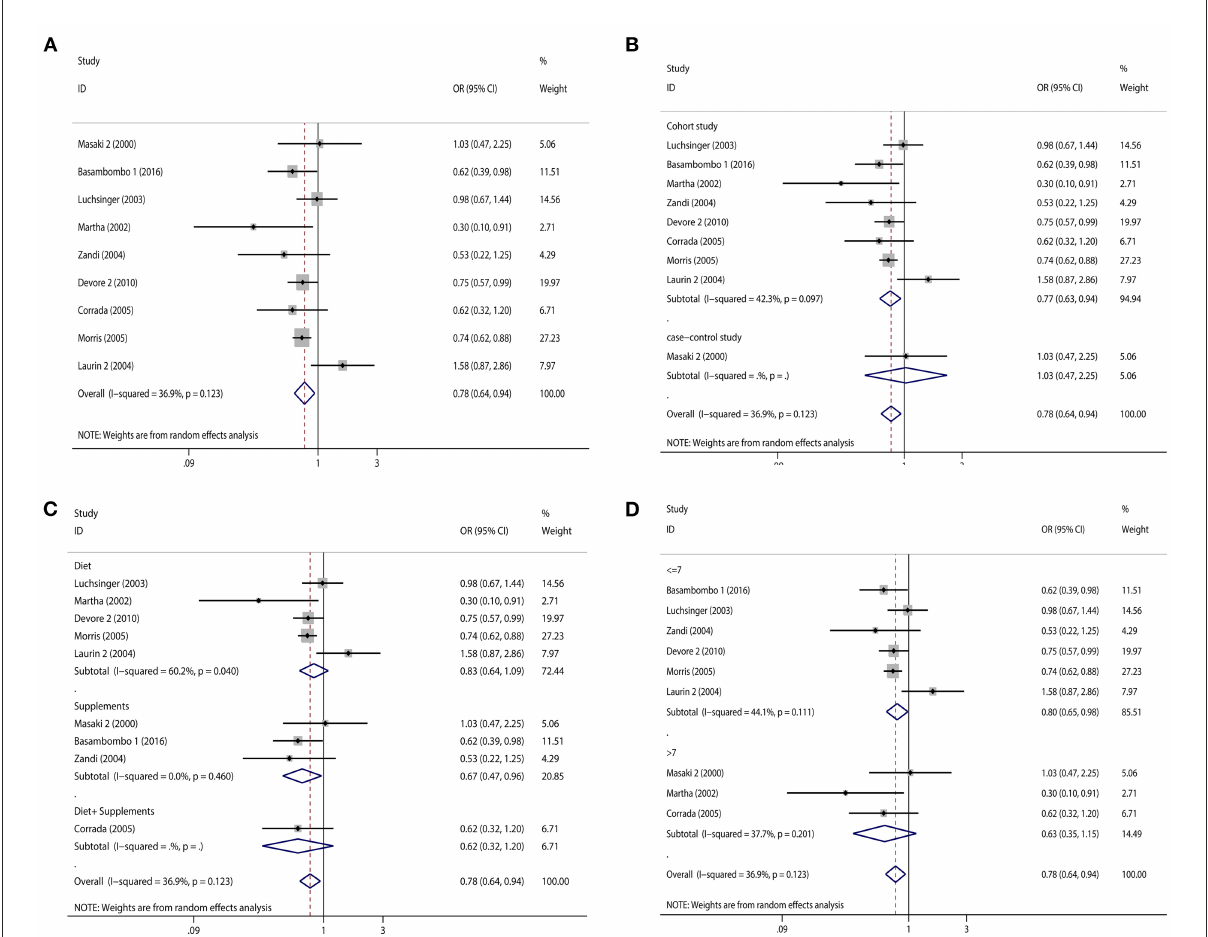
FIGURE3 Forest plots and subgroup analysis plots of high intake of dietary or supplemental vitamin E and risk of AD. (A) Forest plot. (B) Subgroup analysis by study type. (C) Subgroup analysis by diet and supplements. (D) Subgroup analysis by NOS quality